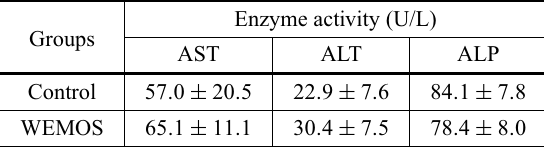
Values are means ± S.D., n = 10